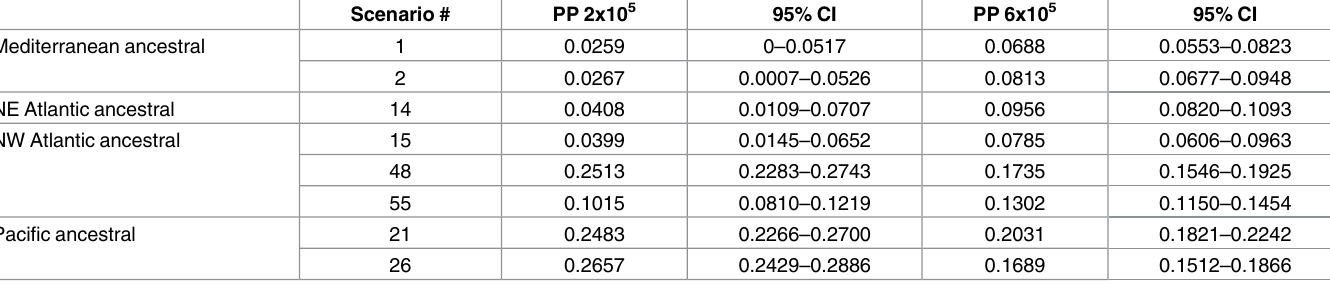
Table 4. Posterior probabilities and 95% confidence intervals (CI) for the most likely dispersal history scenarios when the best scenarios from each ancestral set are compared against each